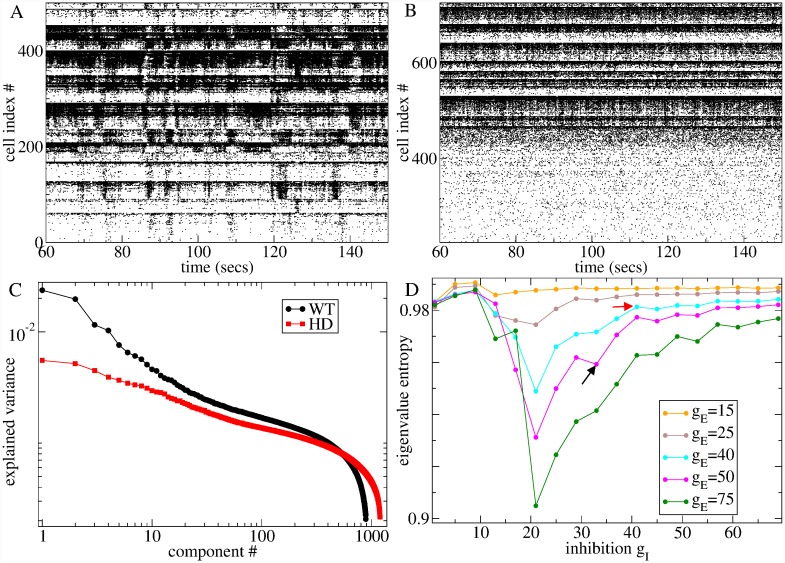
(a,b) Sections of raster plots from the (a) WT and (b) HD best fit network simulations depicted by crosses in Fig 6(f) (WT) and Fig 6(i) (HD) whose ISI statistics are also shown in Figs 8, 9(b), 9(d) and 9(f). (c) Explained variance of the principal components of ensemble rate fluctuations of all active cells for simulations shown in (a, black) and (b, red). (d) Entropy of explained variance distributions for principal components of ensemble rate fluctuations for multiple network simulations at different levels of inhibition gI and excitation gE. Network simulations described in (a,b,c) are indicated by the black (WT) and red (HD) arrows.